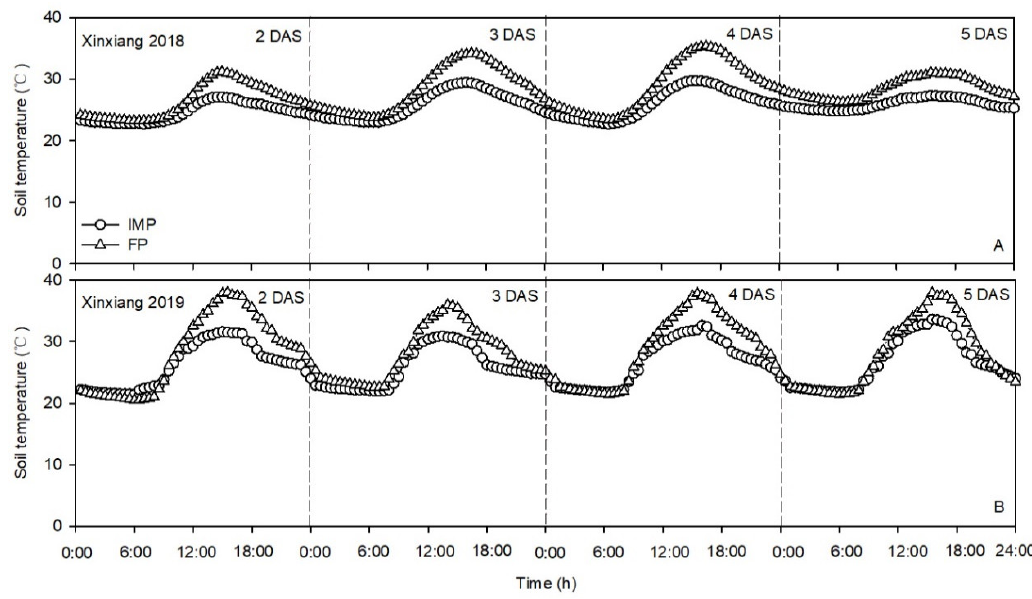
Figure 2. The effects of seeding management practices on soil temperature in the top 0–5 cm of the field in Xinxiang site. DAS, day after seeding. IMP, integrated management practice; FP, farmers’ practice. ( A , B ) represent soil temperatures at Xinxiang site in 2018 and 2019, respectively.